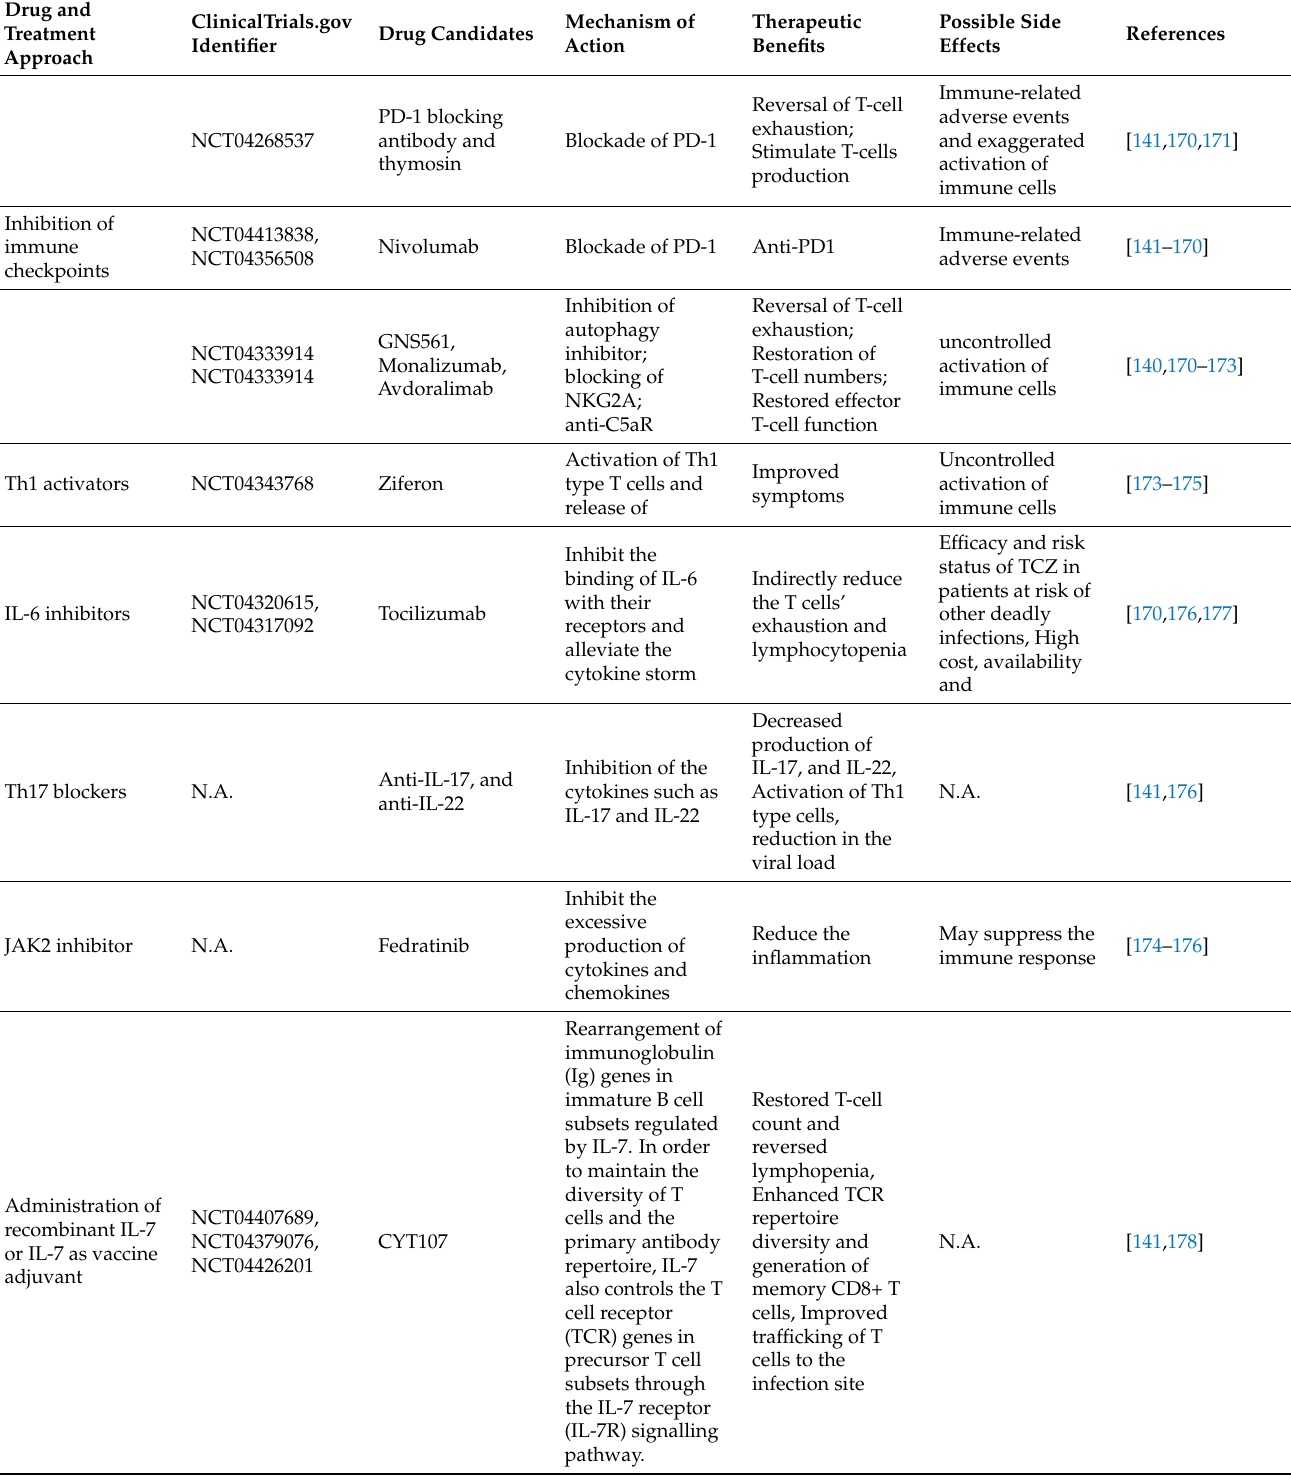
Table 1. Various therapeutic approaches to enhance the T cell-mediated immune response for the management of